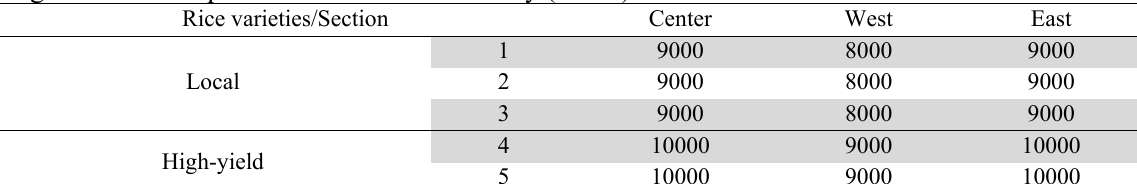
Irrigation water requirement of each rice variety (m 3 /ha) Rice varieties/Section